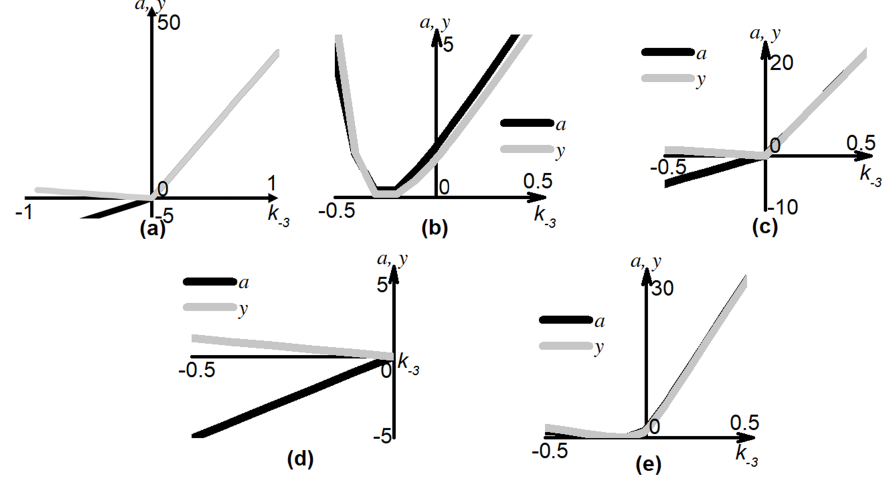
Figure 4. Bifurcation diagrams. Singular point values of a and y for Equation (4) as a function of parameter k − 3 from { − 1, − 0.9, − 0.8, . . . , − 0.1, − 0.01, − 0.0001, 0, 0.0001, 0.001, 0.01, 0.1, . . . , 0.9,